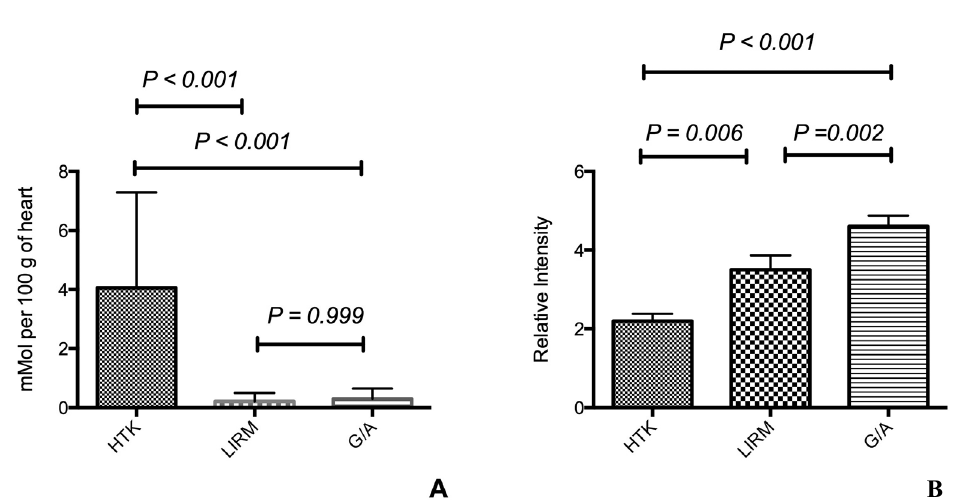
Fig. 2 - The ATP myocardial content was higher in the HTK group compared to the other groups (A). Comparison of caspase 3 activity after 4 hours of cold storage (B). All values are expressed as the means; bars indicate standard error of the mean. Differences were assessed by one-way ANOVA. n=5 animals